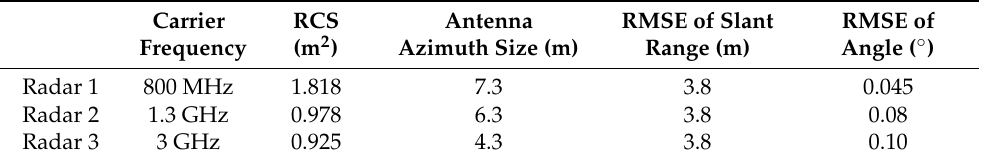
Table 3. RMSE of range and angle of three radars.